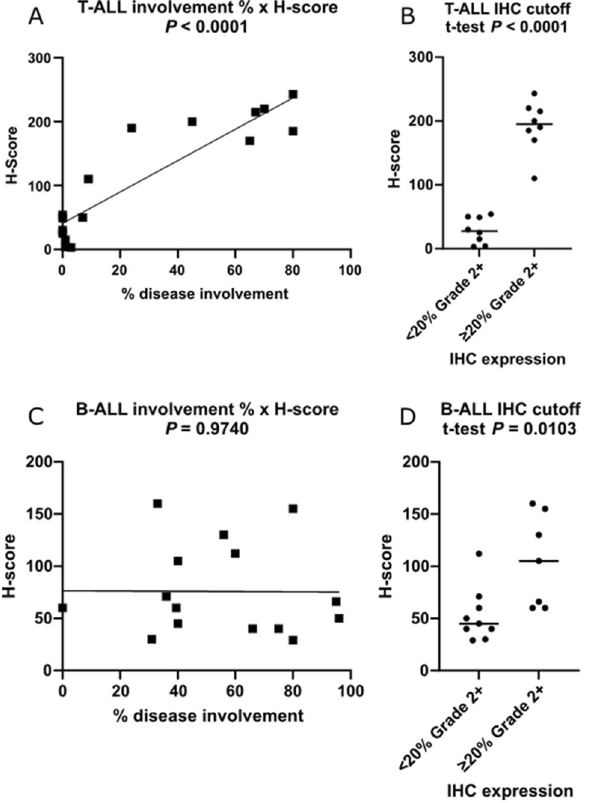
Figure 2. AKR1C3 IHC H-score correlation with ALL blast percentage. Quantification of singleplex nuclear immunoreactivity of AKR1C3 by the H-score in B and T lymphoblastic leukemia/lymphoma among cases with IHC expression of < or ≥ 20% Grade 2 +. Correlation with disease involvement is significant in T-ALL, but not B-ALL.